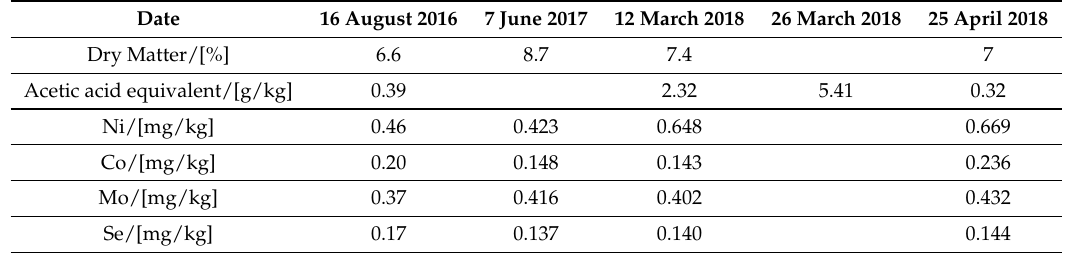
Table 2. Lab results biological supervision including trace elements concentration from the last 2 years. Lowest Cobalt concentration is found on the 12 March 2018. Dry Matter method (VDLUFA I, A 2.1.1; 1991 (mod.)), Acetic acid equivalent method (VDLUFA II, 3.2.6, 1995), Ni, Co, Mo, Se method (DIN EN ISO 17294-2; 2005-02